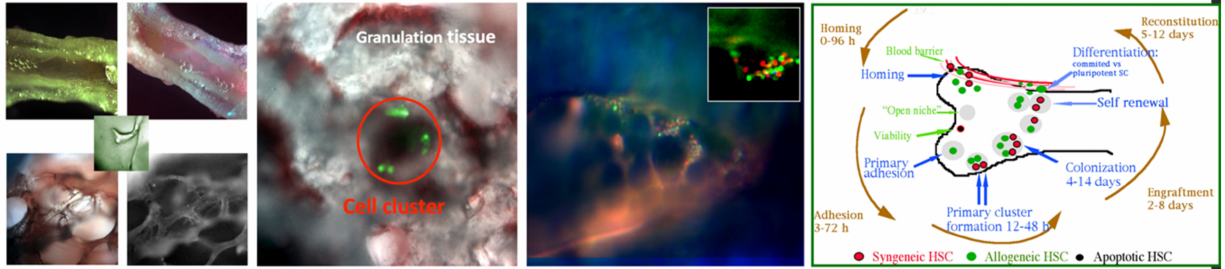
Figure 18. Imaging hematopoietic cell engraftment and survival in the recipient bone marrow. Far left: Intravital microscopy in a bone window. In vivo BM in reflected light ( left ) and UV-excited autofluorescence ( right ), at different magnifications reveals resolution, trabecular structure, good survival. Middle left: Formation of a primary cellular cluster. In vivo BM imaging 3 days after I.V. injection of syngeneic BMC in busulfan-conditioned B10 mice. Superposition of brightfield and fluorescence. (20x). Middle right: FRET imaging viability assay. After 20 days in vivo, stem cells engrafted into the marrow were imaged by Fluorescence Resonance Energy Transfer to distinguish live cells (green) from dead (red), at 10x magnification. Far right: Topologic/mechanistic steps (homing, adhesion, engraftment, reconstitution) that can be inferred from imaging HSCs in vivo